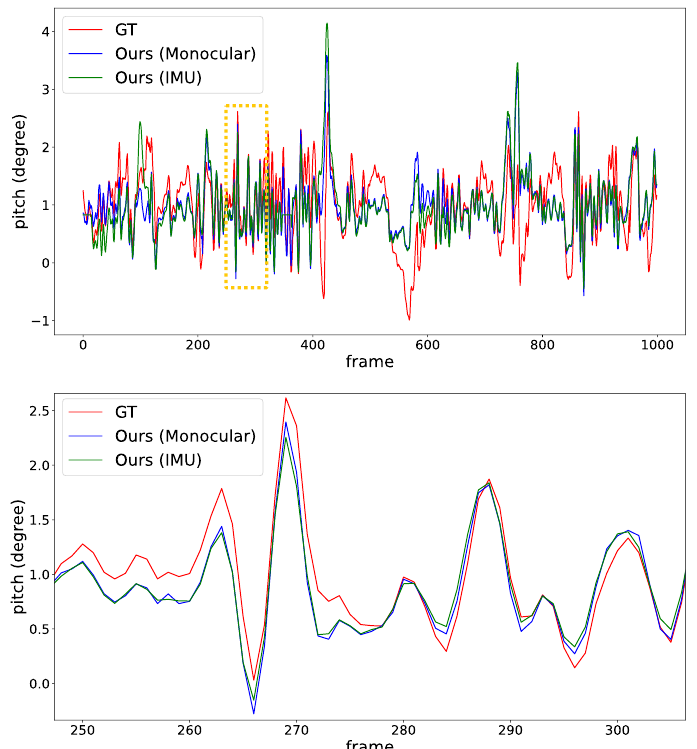
Figure 8. Plots of pitch angles with normal vectors calculated by the proposed methods. The bottom plot shows the details within 50 frames from the orange box. The oscillation tendency of the pitch angles from the proposed methods aligns well with the ground truth. Note that the overall amplitude of the pitch angles is actually small, usually within 1 degree.